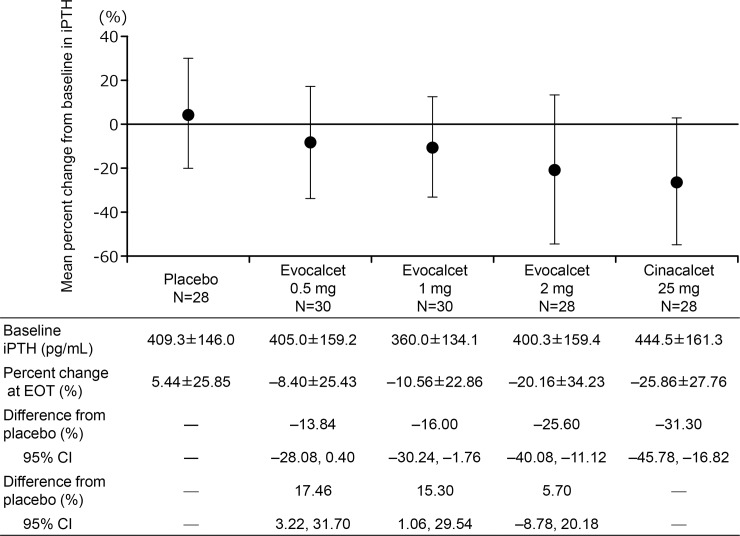
Point estimate of percent changes in iPTH at EOT.The error bars indicate standard deviation. iPTH, intact parathyroid hormone; EOT, end of treatment; CI, confidence interval.